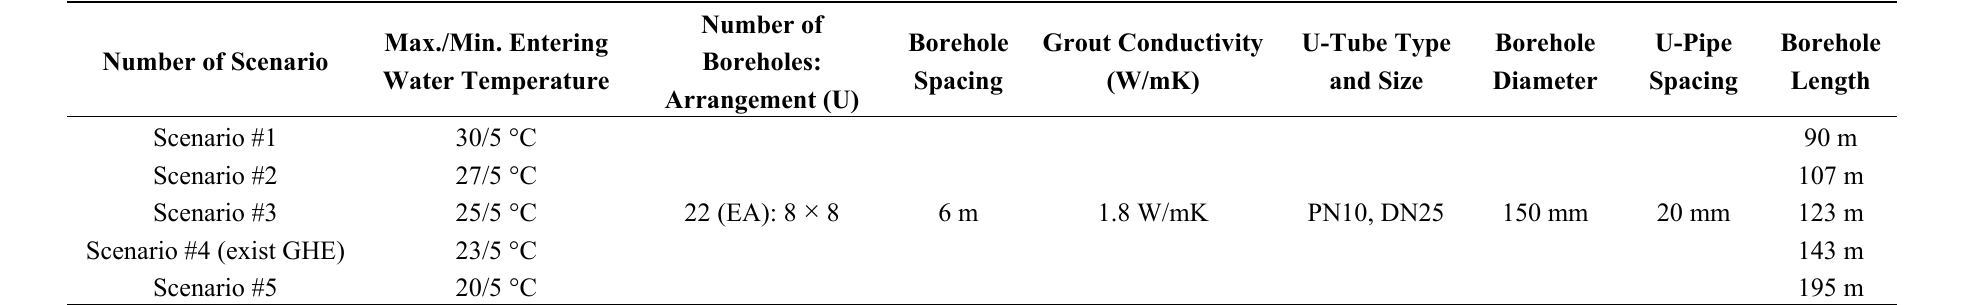
Table 4. Target scenarios (length of borehole) of GHE considering EWT and characteristics of